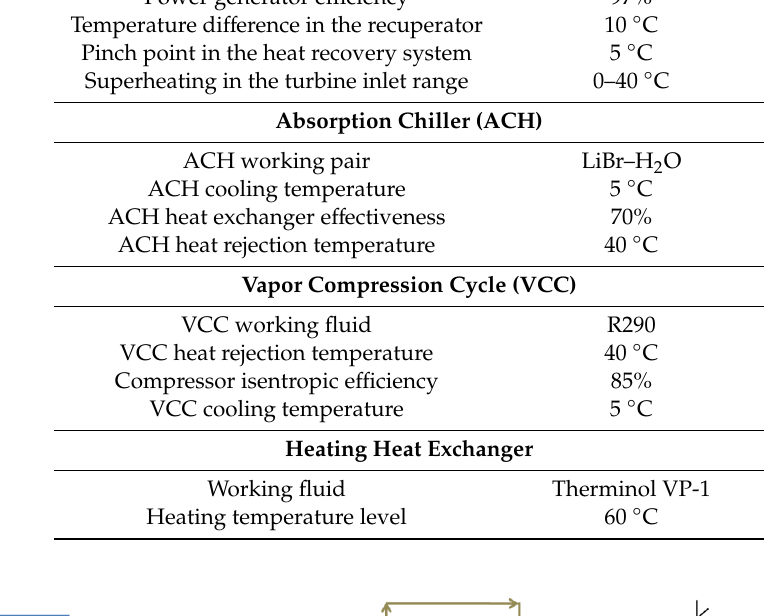
Table 2. Main data of the examined devices in the trigeneration systems.